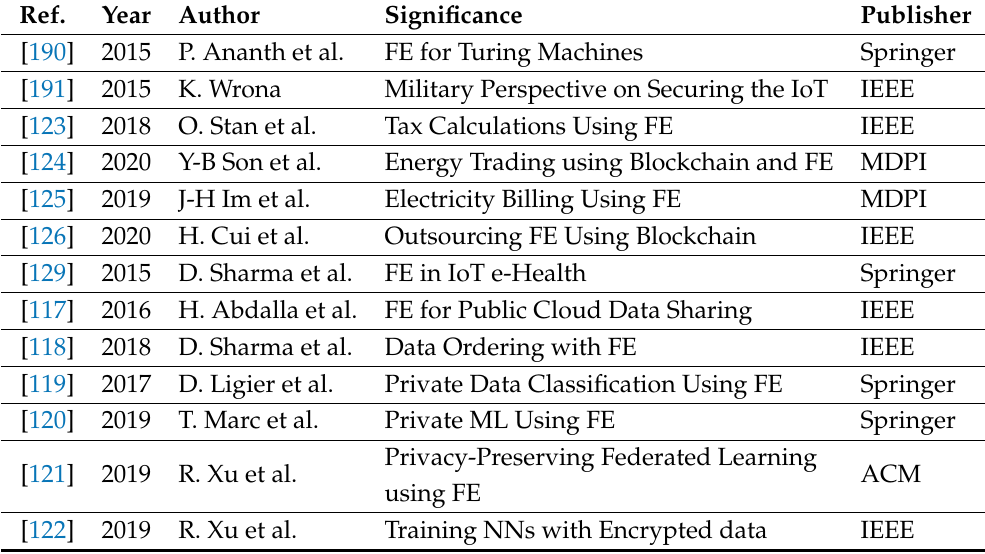
Table 6. Significant IoT-related literature for FE in the last decade.